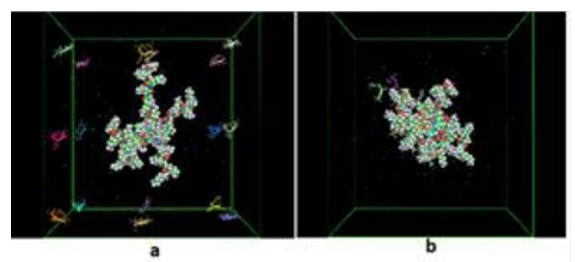
Fig. 1. Stages of the complex formation (initial and final) between dendrigraft and 16 molecules of KED peptide at time: t = 0 (a); t = 100 ns (b). .